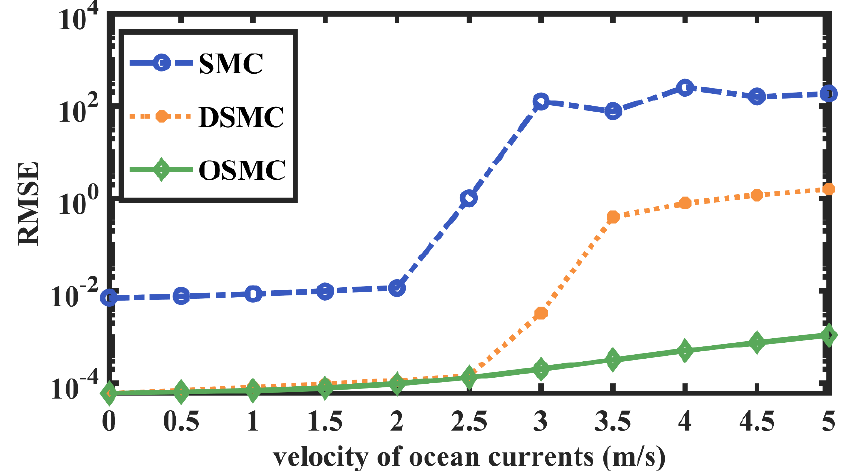
Figure 9. The variation in RMSE of the tracking trajectory for three control schemes, when ocean current velocities vary between 0 m/s and 5 m/s. current velocities vary between 0 m/s and 5